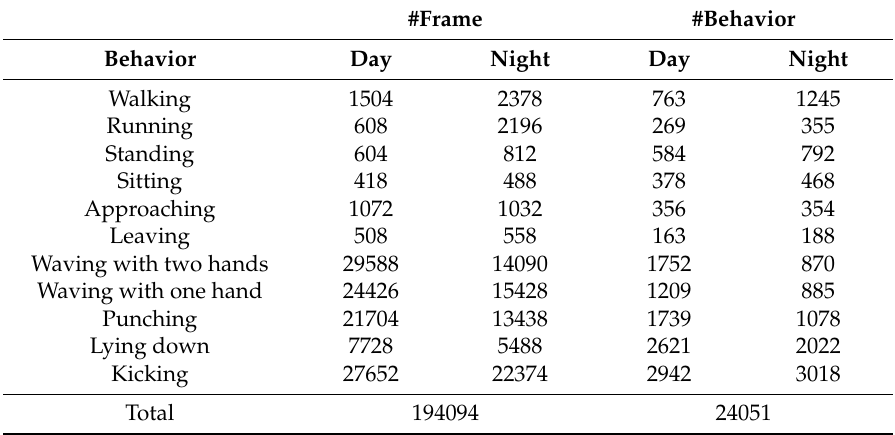
Table 4. Numbers of frames and the types of behavior in each dataset.